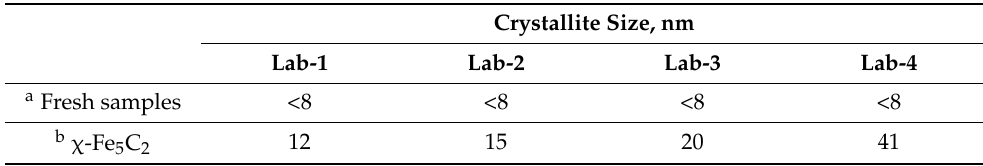
Table 4. The crystallite size of the fresh samples (oxide) and χ -Fe 5 C 2 over the spent samples after FTS reaction (c.a. 280 h).